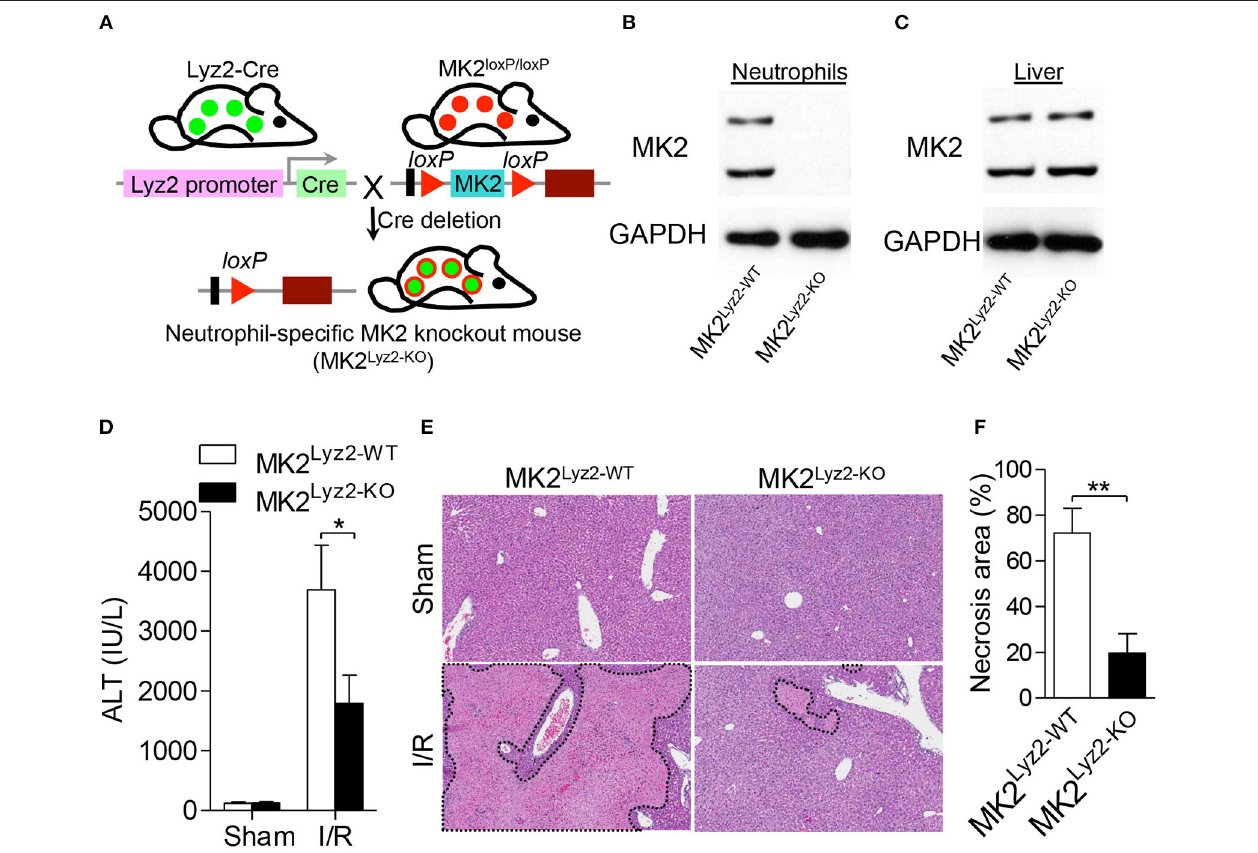
FIGURE 8 | Myeloid-specific deletion of MK2 decreased hepatocellular damage in hepatic I/R injury. (A) Schematic representation of the generation of MK2 Lyz2 − KO and MK2 Lyz2 − WT mice that MK2 loxP / loxP mice were bred with Lysozyme (Lyz2)-Cre transgenic mice. The protein level of MK2 in neutrophils (B) and livers (C) from MK2 Lyz2 − KO and MK2 Lyz2 − WT mice was detected by western blot. MK2 Lyz2 − KO and MK2 Lyz2 − WT mice were subjected to hepatic I/R injury with 60min of ischemia and 16h of reperfusion. Serum and injury livers were collected for analysis. (D) Serum ALT levels were measured. (E) Representative H&E stained sections of injury livers were shown. Original magnification × 100. (F) The necrosis area was measured by ImageJ software. The results are shown as means ± SEM. * P < 0.05; ** P < 0.01, based on 5 mice in each